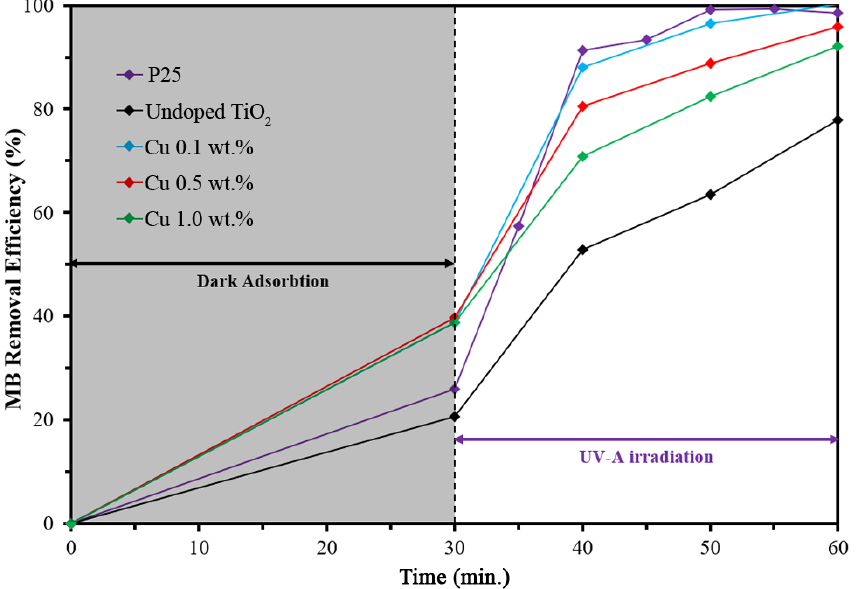
Figure 5. Photocatalytic activity of undoped and Cu-doped TiO 2 nanoparticles for methylene blue (MB) degradation.